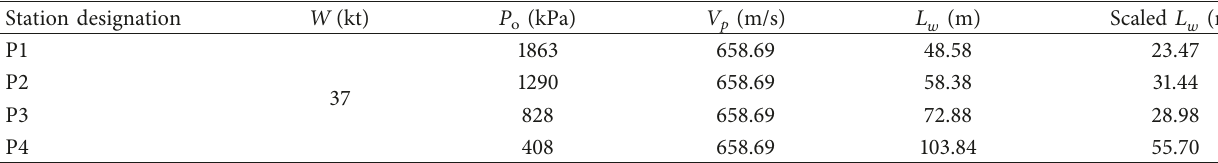
Table 4: Scaling of attenuation characteristic length ( L